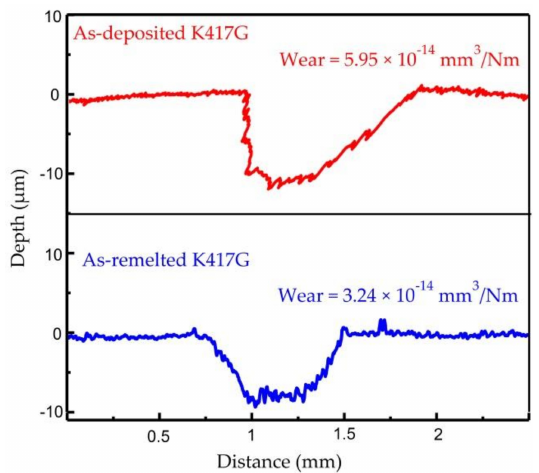
Figure 19. The 2D profiles of the wear track of the as-deposited K417G and as-remelted K417G tested against Si 3 N 4 balls.